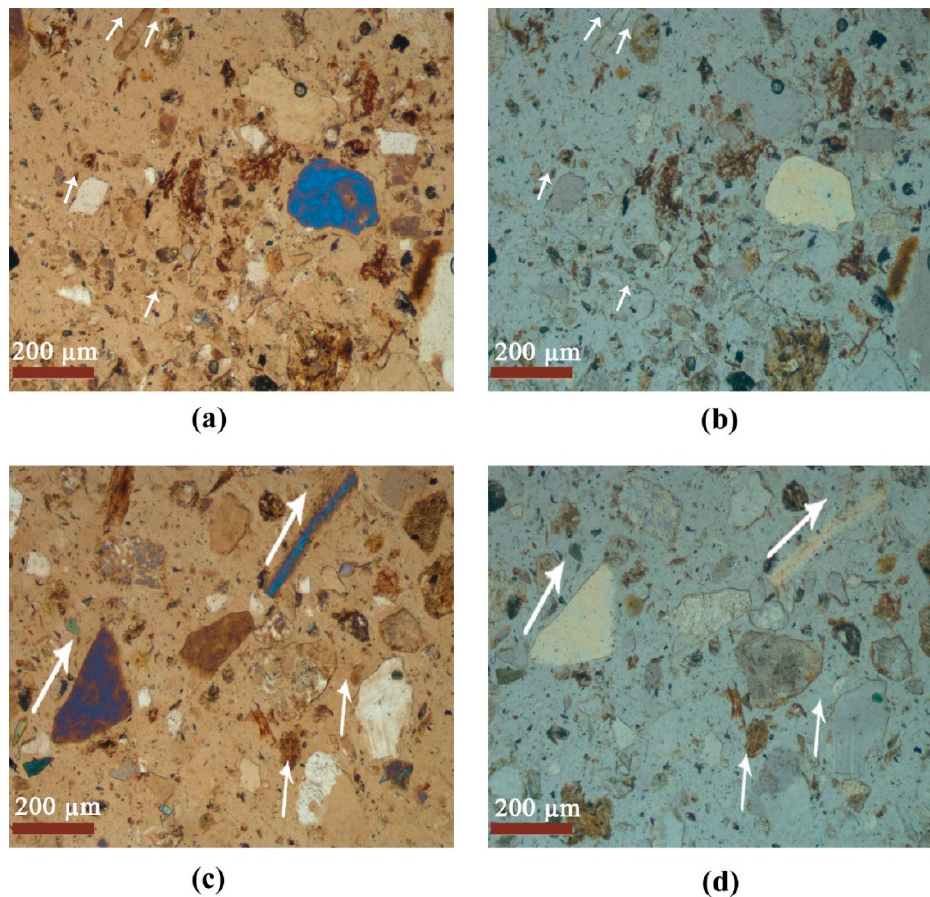
Figure 4. Vertical orientation of rock in study soil from first terraces (S 2 − 1). ( a , c ) Plane polarized light; ( b , d ) crossed polarized light.